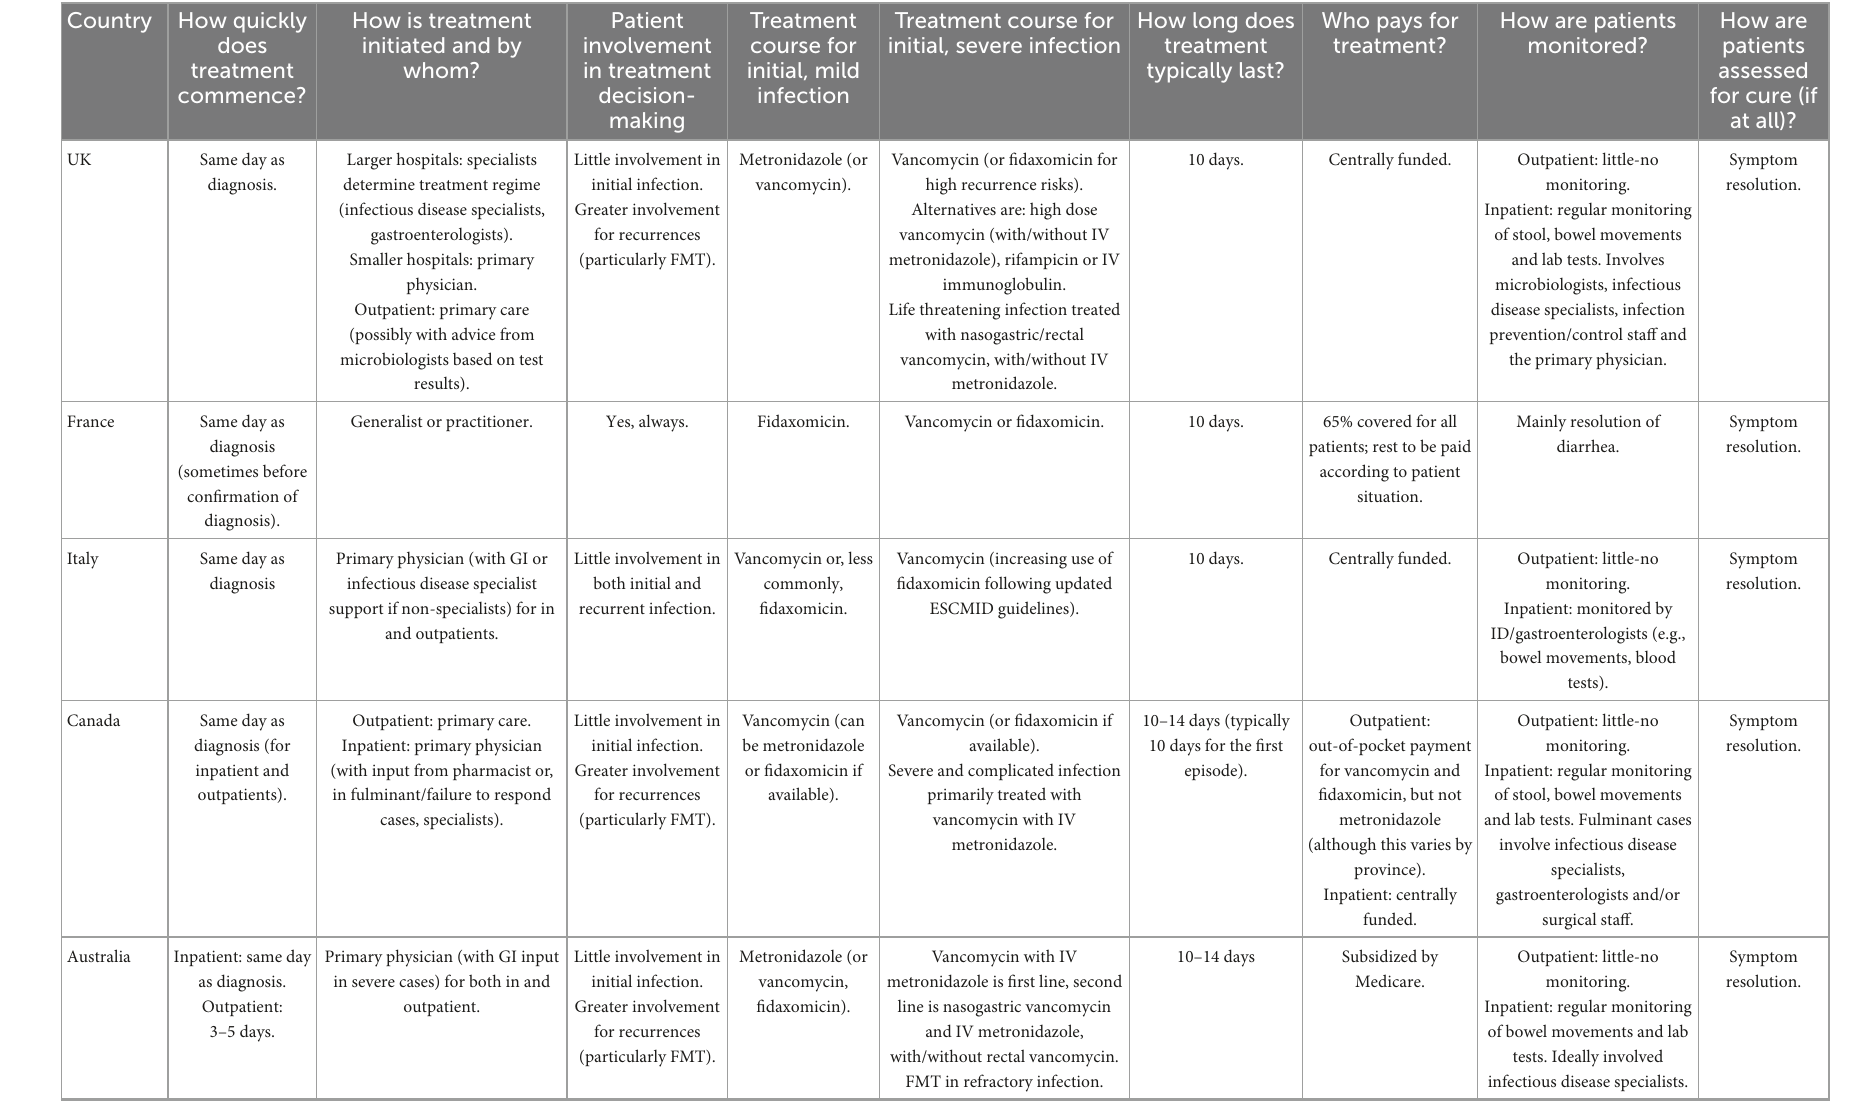
TABLE 2 Treatment of initial infection, and patient monitoring and follow-up.